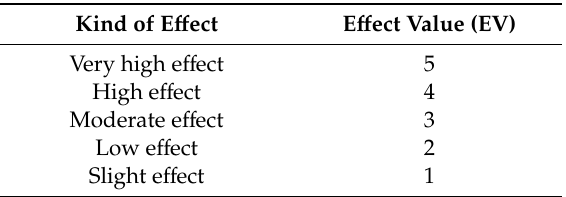
Table 3. Classification of each e ff ect